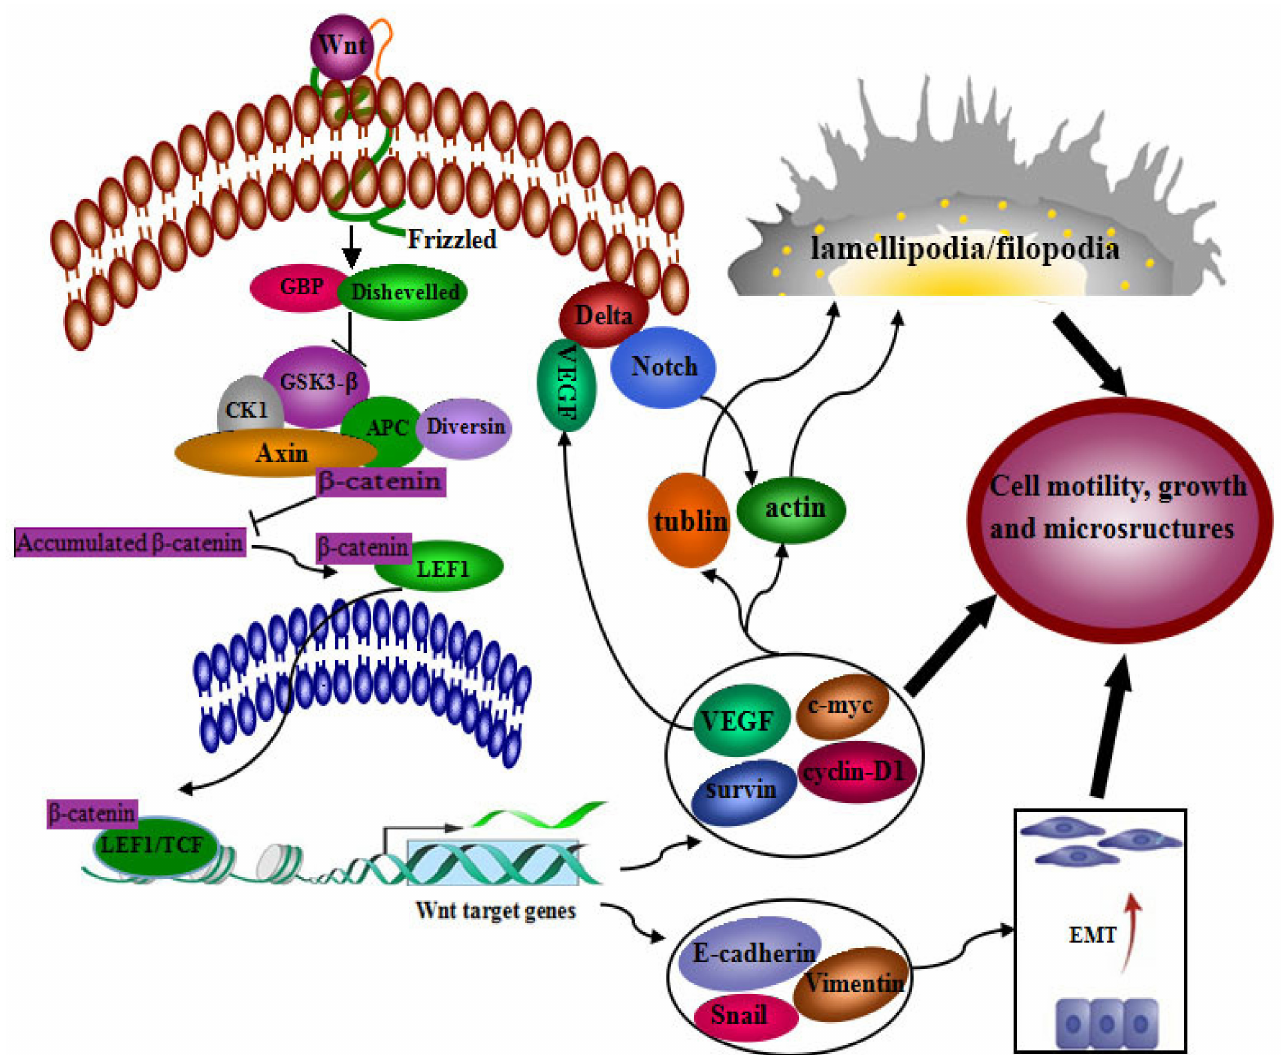
Figure 6. The signaling pathway of LEF1 in tumor